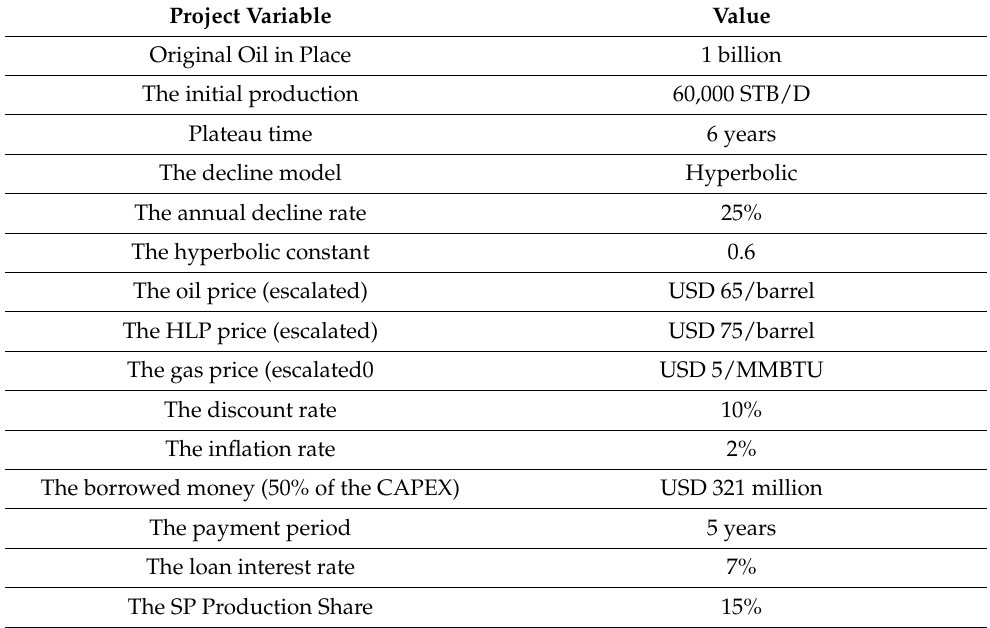
Table 2. The capital expenditure and operating costs of AA